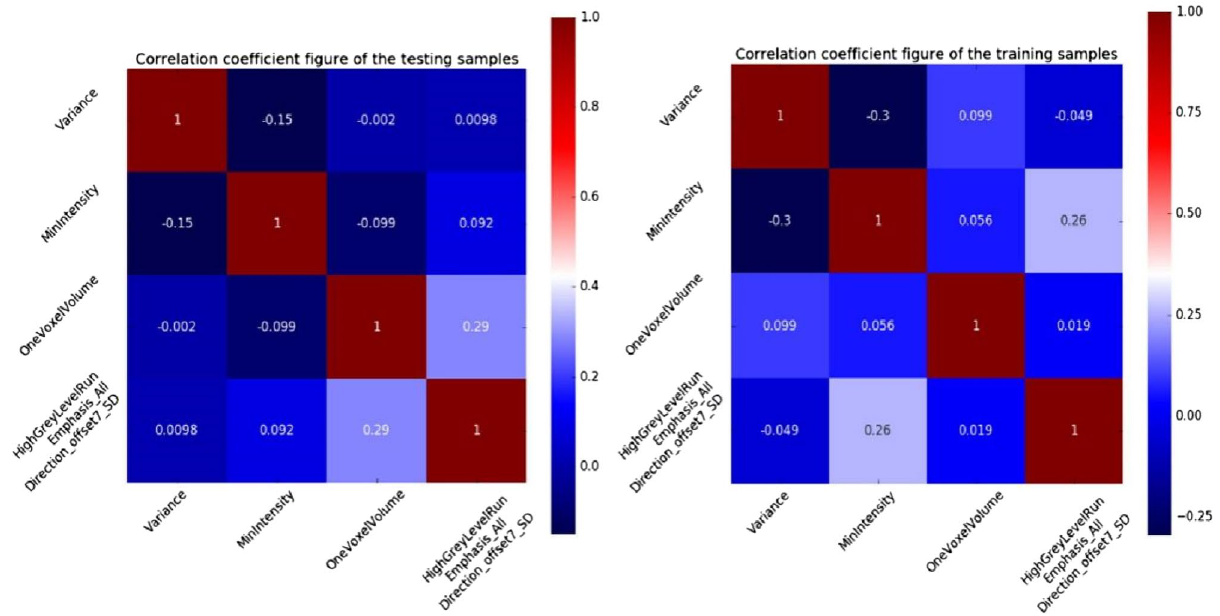
Figure 4. Correlation coefficients between four features in the samples in the training and test sets. The coefficient factors between the four features were all < 0.3, indicating no linear relationship, and could be used as independent predictive